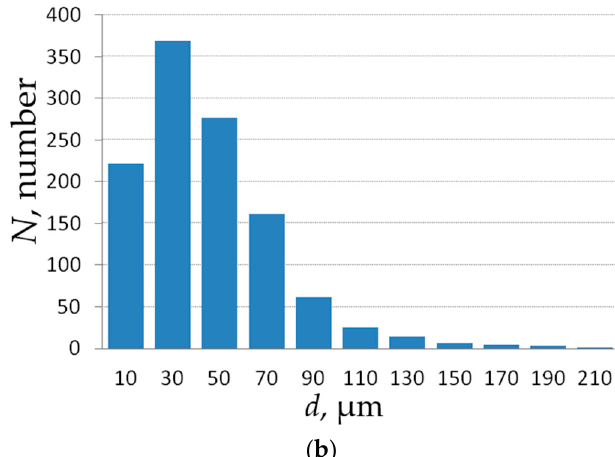
Figure 10. Result of image processing ( a ) and the size distribution histogram ( b ) of blisters on the surface of 99.996% fine-grained copper. The frame size is 9 mm horizontally and 4 mm vertically ( a ).